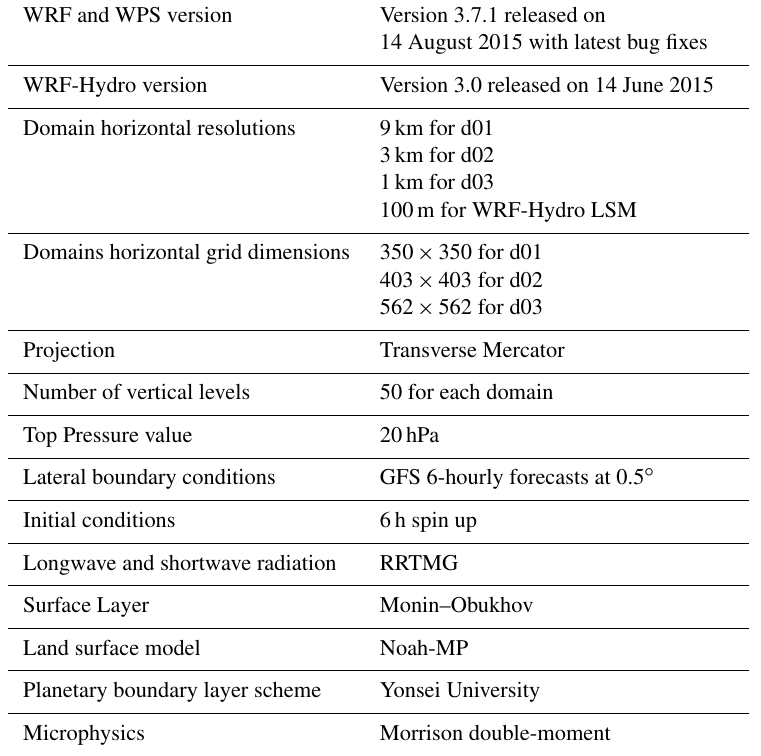
Table 1. WRF and WRF-Hydro model